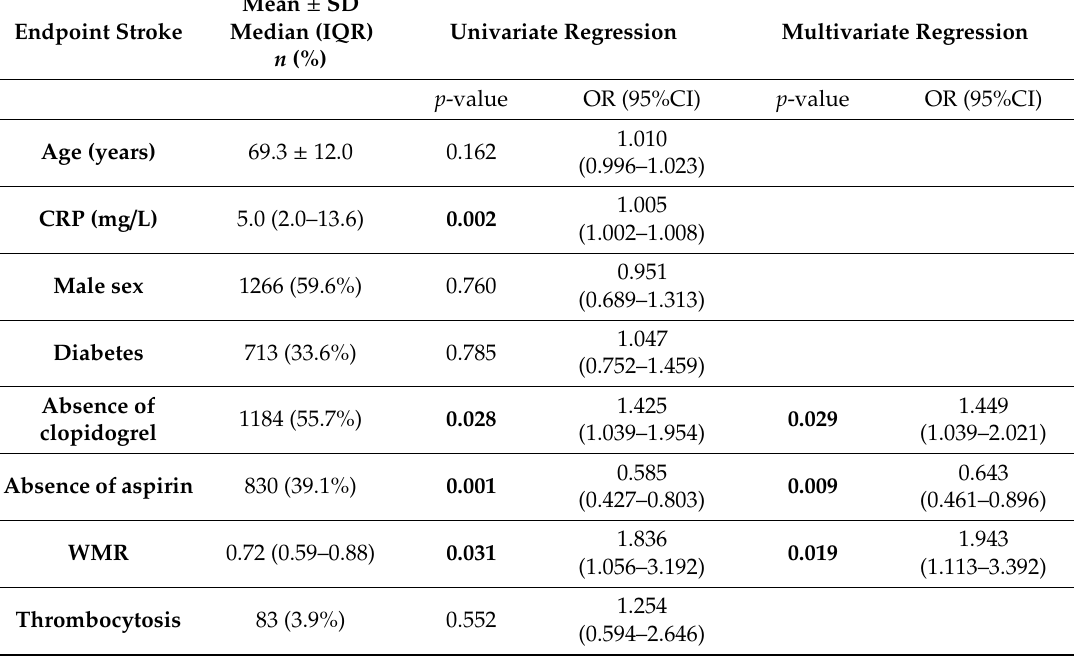
Table 4. Univariate and multivariate regression analysis for the endpoint of